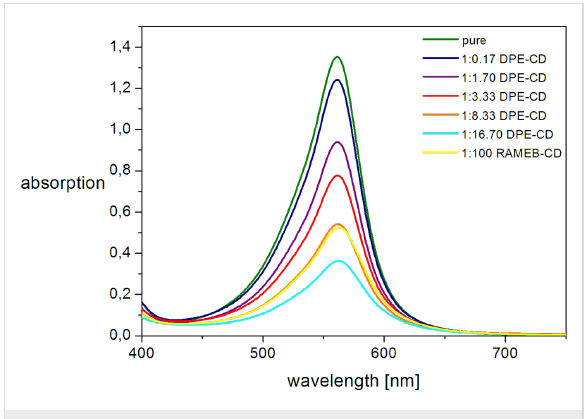
Figure 3: UV–vis spectra of PEG-PP solutions containing different amounts of DPE-CD and RAMEB-CD .